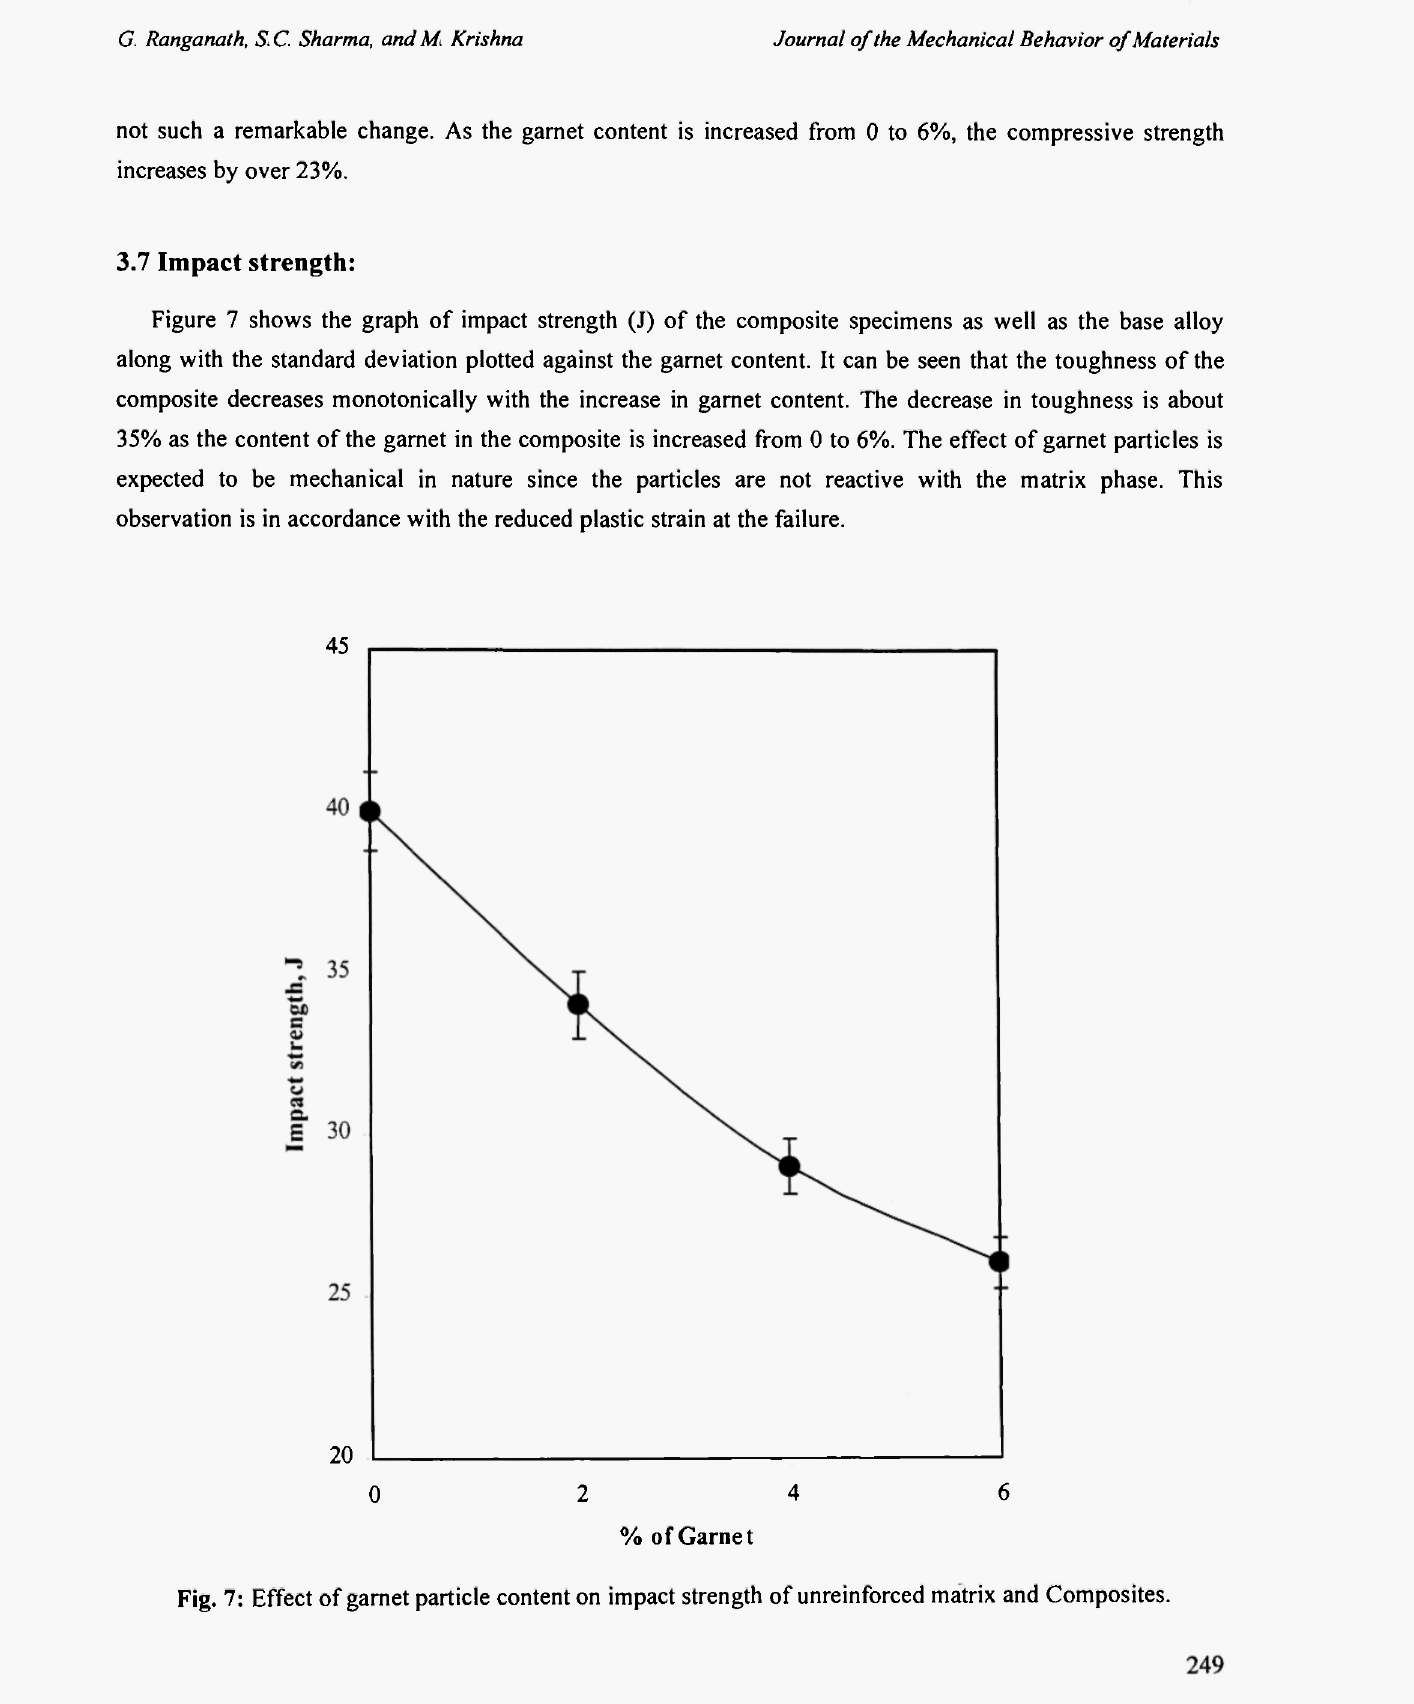
Fig. 7: Effect of garnet particle content on impact strength of unreinforced matrix and